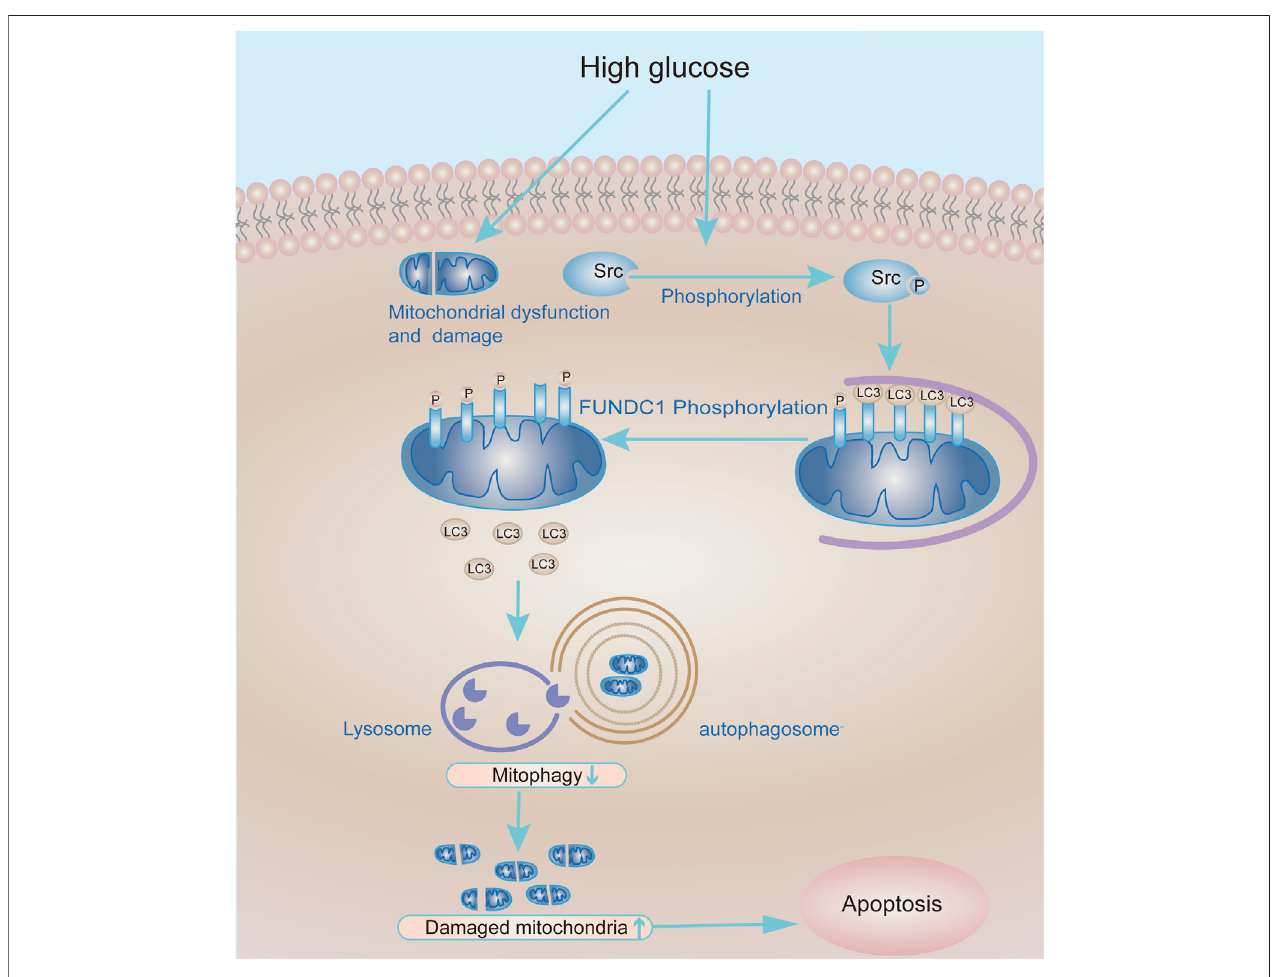
FIGURE8 | Working model ofthe molecular mechanism whereby Src inhibits mitophagyunder HGconditions tocause podocyte injury. Under HG conditions, the expression and activity of Src are up-regulated in podocytes, leading to increased phosphorylation and inactivation of FUNDC1. In turn, this reduces the recruitment of LC3II to mitochondria and decreases mitophagy. Accumulation of damaged mitochondria in podocytes compromises their function and leads to podocyte apoptosis.